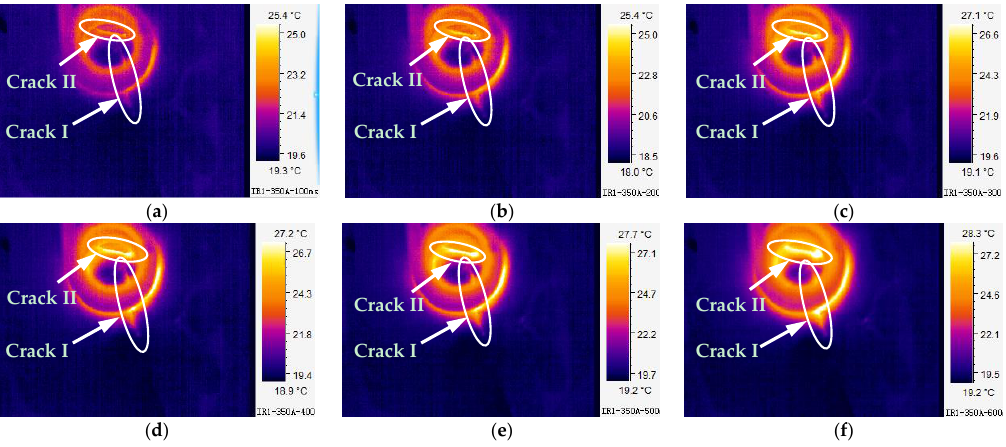
Figure 5. IR image recorded at ( a ) 100 ms, ( b ) 200 ms, ( c ) 300 ms, ( d ) 400 ms, ( e ) 500 ms, and ( f ) 600 ms when the coil is placed on Position D shown as Figure 4b.